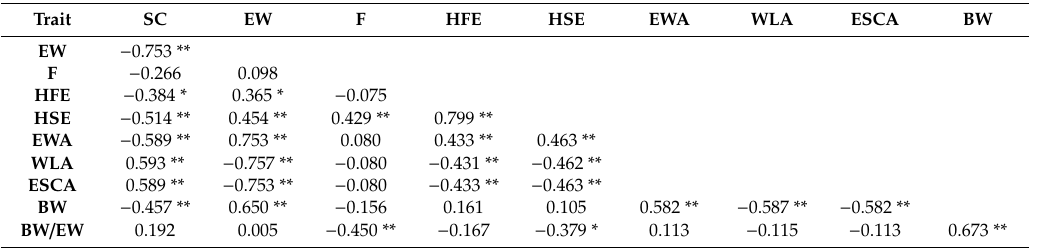
Table 5. Relations (Spearman correlation coe ffi cients) between measurable traits of Japanese quail hatching